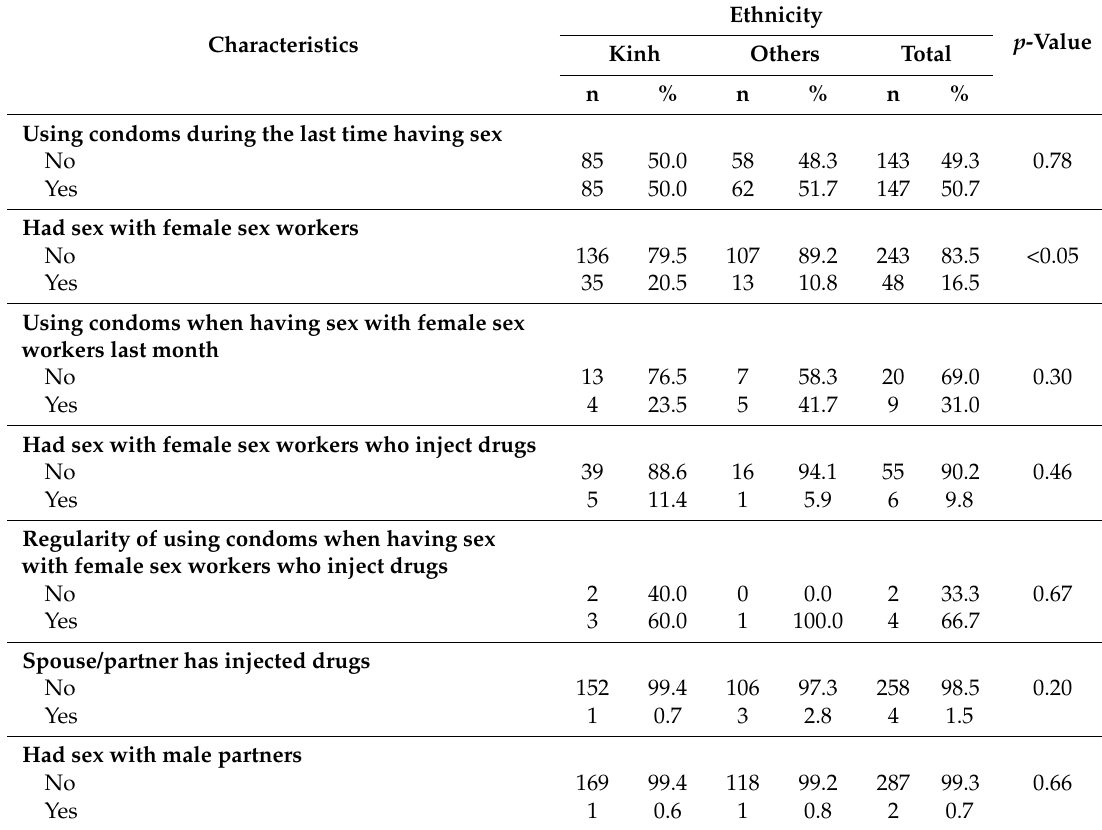
Bold numbers represent statistical